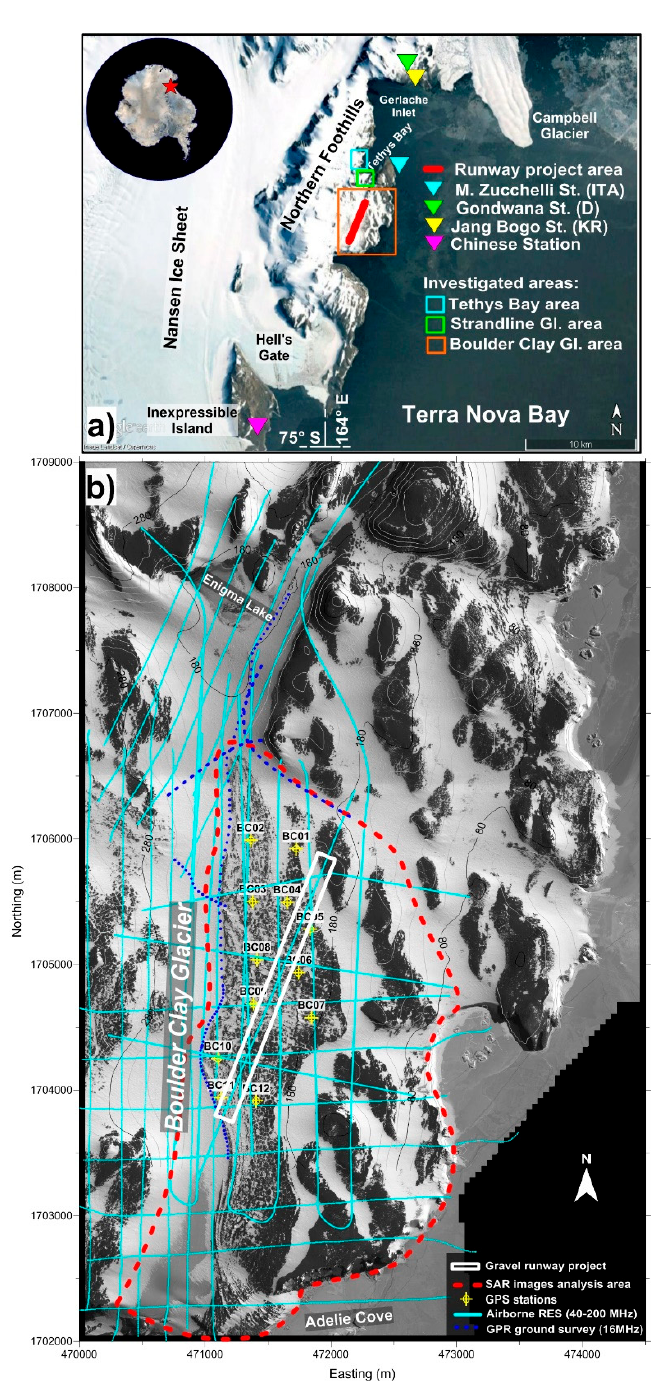
Figure 1. Geographical localization of the study area (a) and geophysical investigations carried out on Boulder Clay Glacier (BCG) area (b).